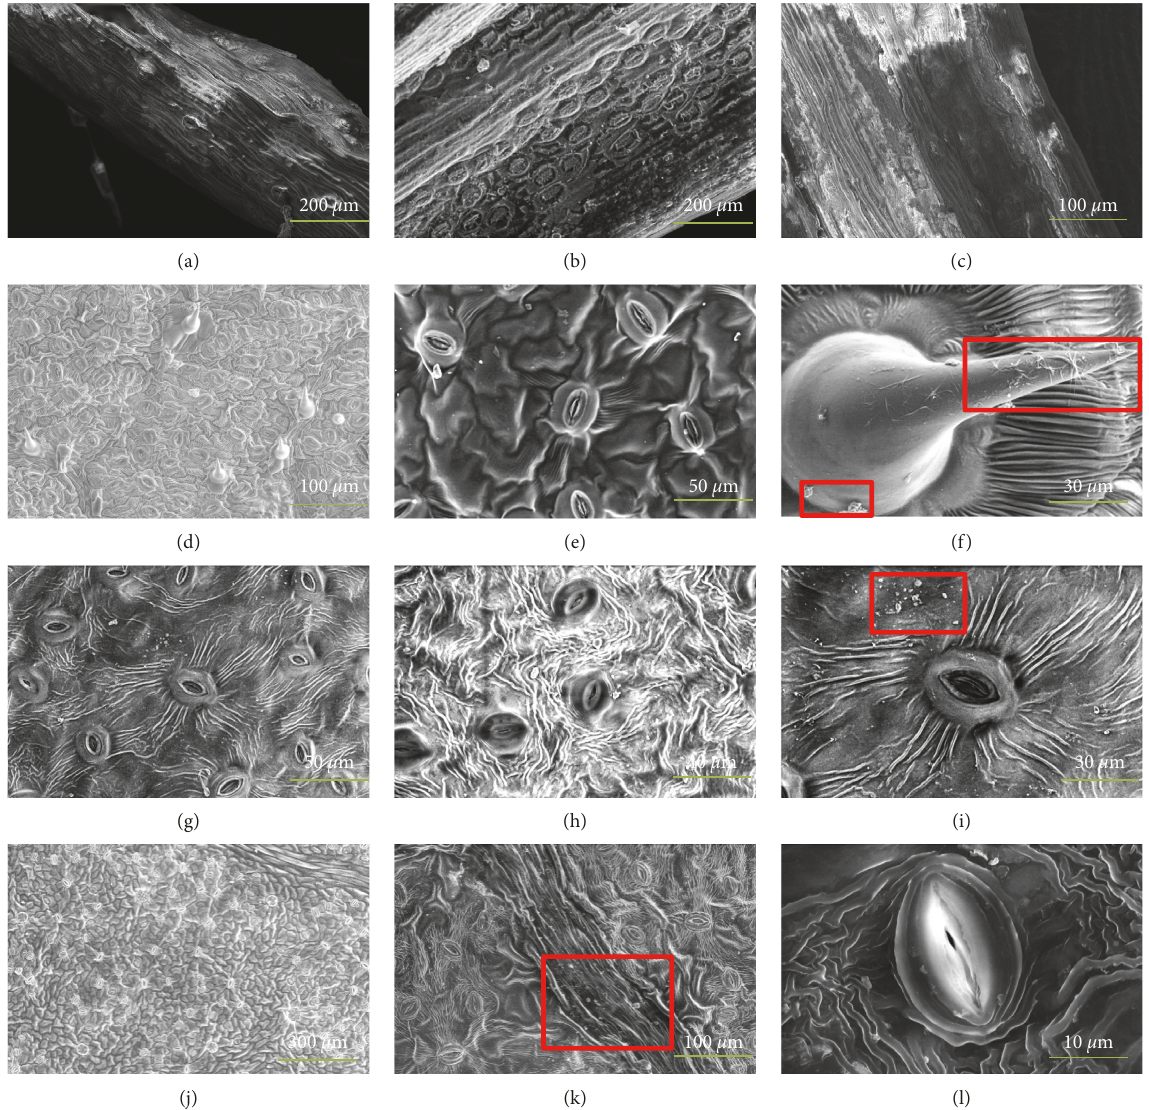
Figure 6: Microstructures of different species with SEM. (a–c) Leaf surface of Pinus ( × 500; × 600; × 1000); (d) adaxial leaf surface of Hemiptelea ( × 1000); (e) stomata of the abaxial leaf surface of Hemiptelea ( × 2000); (f) the base of one of a dense mat of glochid trichomes of Hemiptelea ( × 4000); (g) adaxial leaf surface of Buxus ( × 2000); (h) abaxial leaf surface of Buxus ( × 3000); (i) one stomata of the abaxial leaf surface of Buxus ( × 4000); (j) adaxial leaf surface of Syringa ( × 400); (k) abaxial leaf surface of Syringa ( × 1000); (l) one stomata of the abaxial leaf surface of Syringa ( × 8000). The structure in the the red rectangle is more inclined to capture particulate